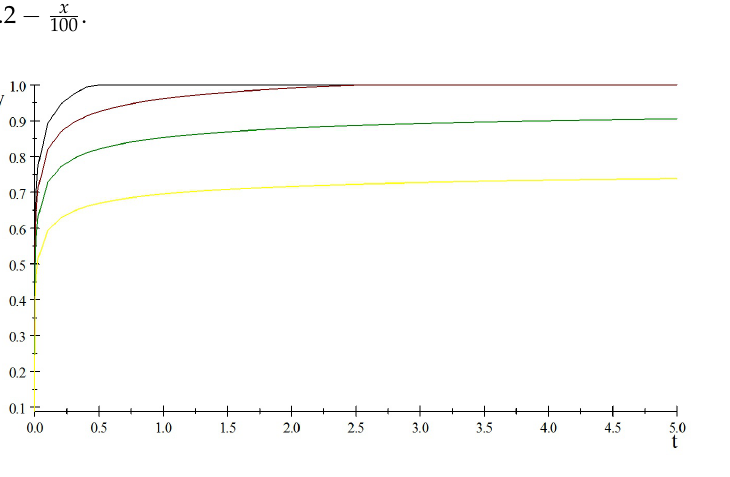
(cid:16) Figure 5. The plot of y for (cid:98) α = 0.2949511, (cid:98) β = 35, q = 0.5, u ( x ) = − 4, b ( x ) = 0.2 − Figure 6 displays the plot of y for (cid:98) α = 0.2949511, (cid:98) β = 35, q = 1, u ( x ) = − 4, b ( x ) = . 0.2 − x 100